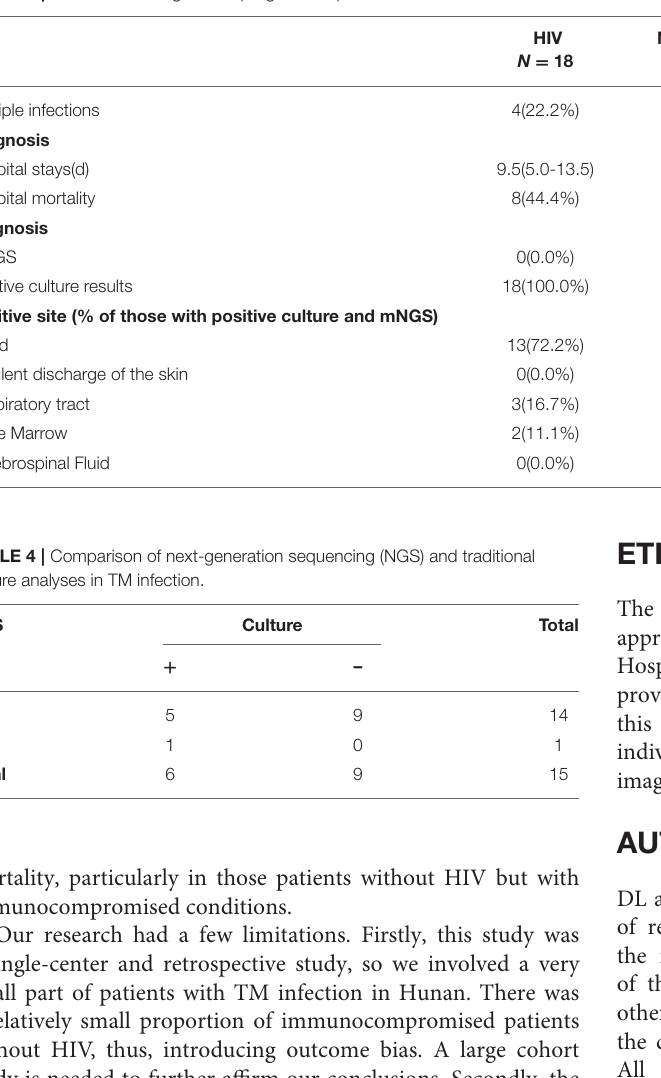
TABLE 3 | Treatment strategies and prognosis in patients with TM infection.